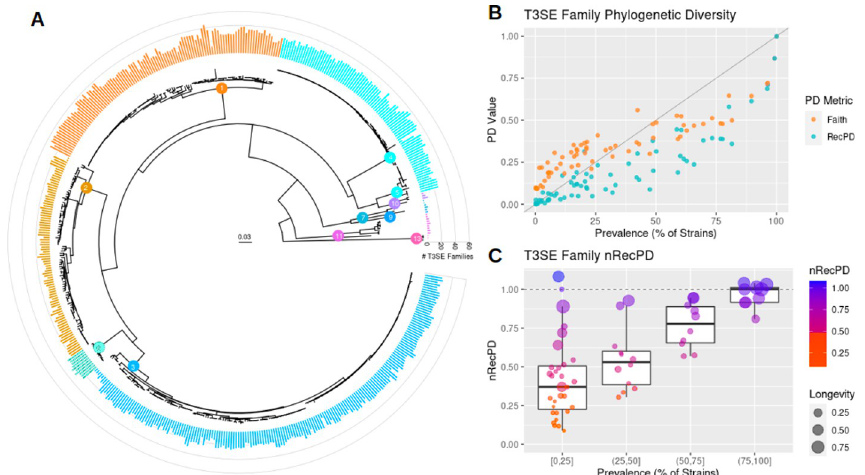
Fig 6. RecPD reveals significant impact of recombination in the phylogenetic distributions of P . syringae effector families. (A) Core genome phylogeny of the P . syringae species complex, with internal tree nodes indicating P . syringae phylogroups. The outer ring barplot shows the total number of distinct effector families carried by each strain and coloured according to strain phylogroup designation. (B) Plot of effector family prevalence against RecPD(NN) and Faith PD for all 70 effector families. (C) Effector family RecPD values normalized by Faith’s PD, binned by effector family prevalence. The point size indicates effector family longevity.